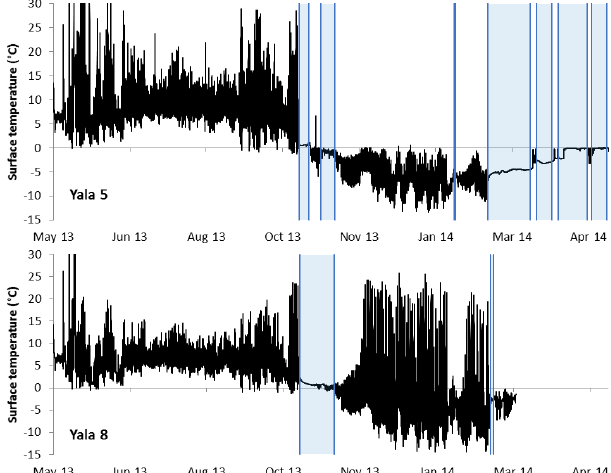
Figure 3. Observed surface temperature with 10min interval at two locations (Table 1). The blue vertical lines indicate the start and end of the snow